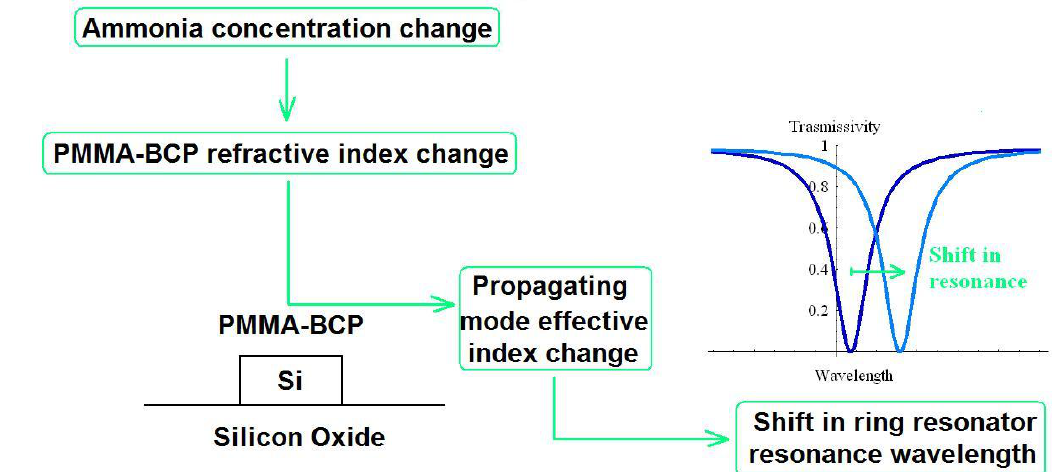
Figure 2 . Proposed ammonia sensor operating